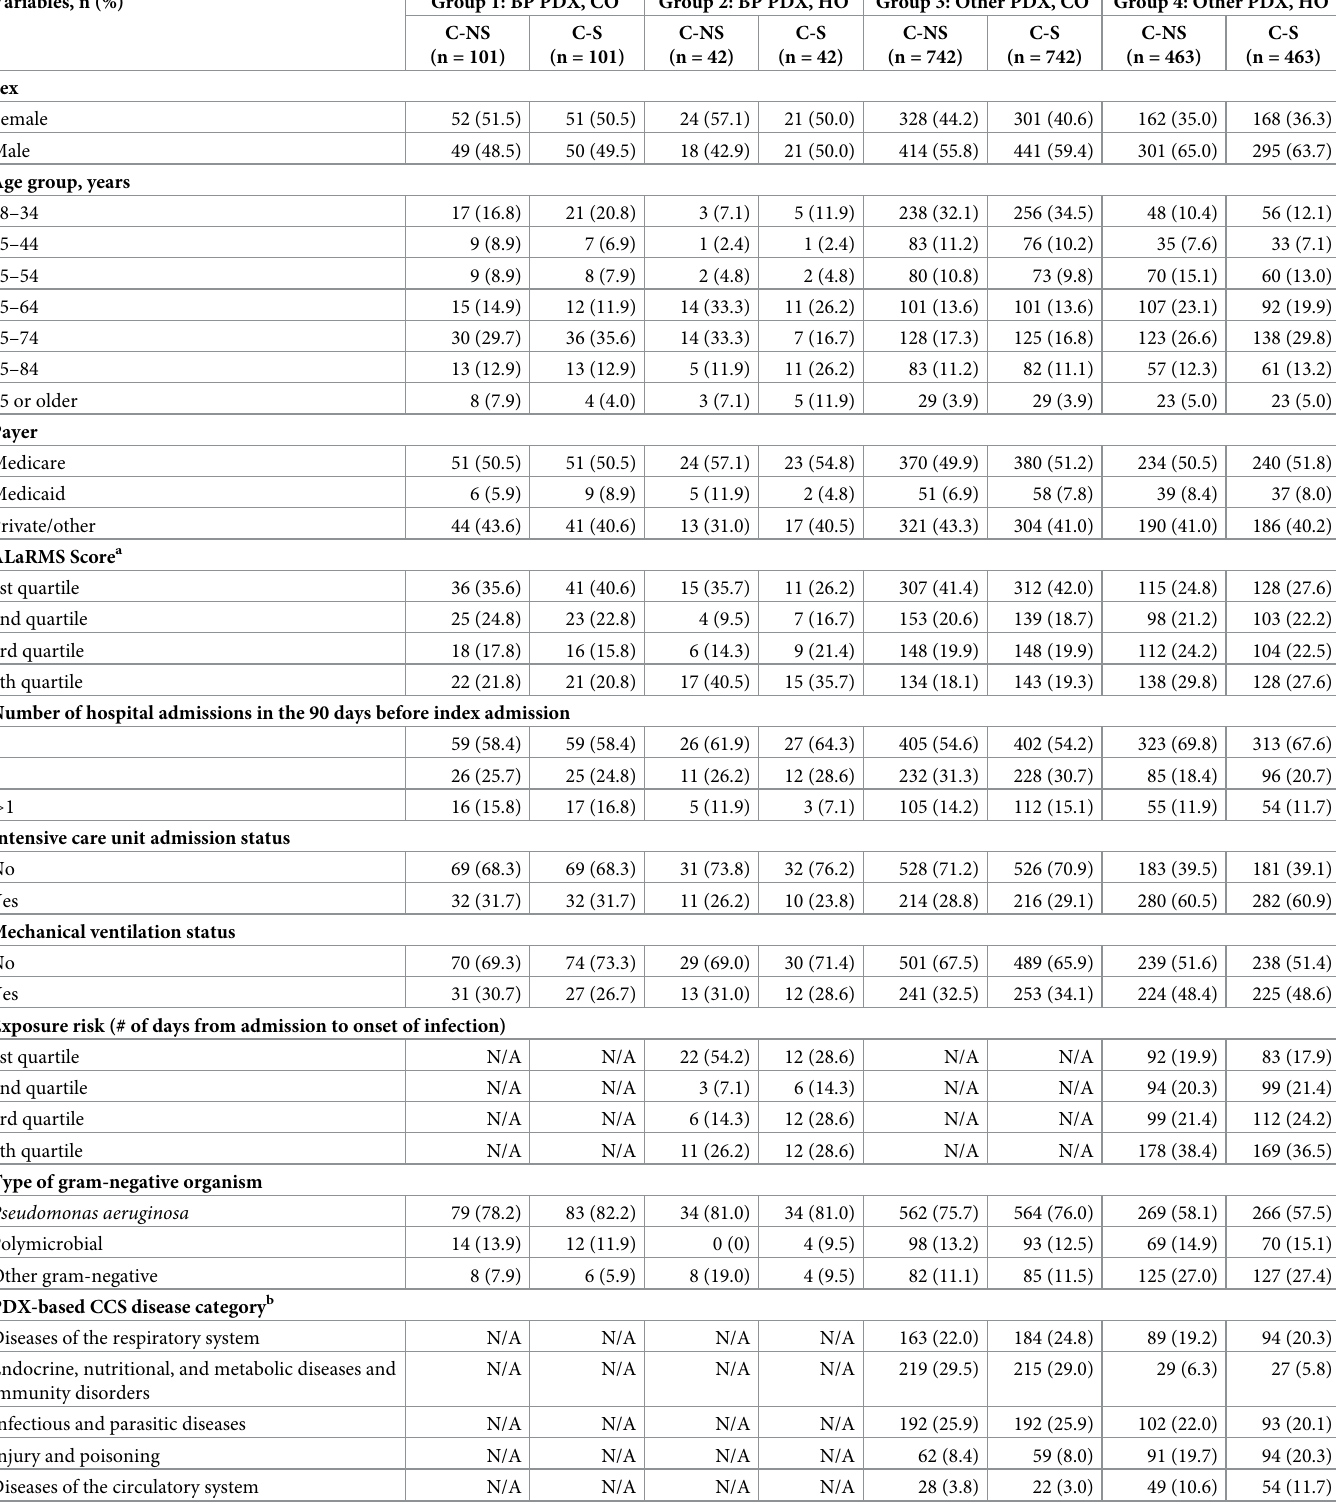
Table 1. Distribution of patient characteristics after propensity score